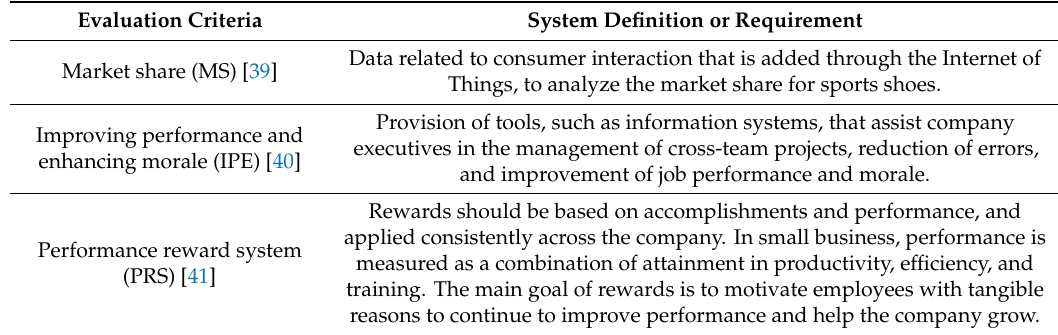
Table 2. Evaluation criteria and system definition or requirement.